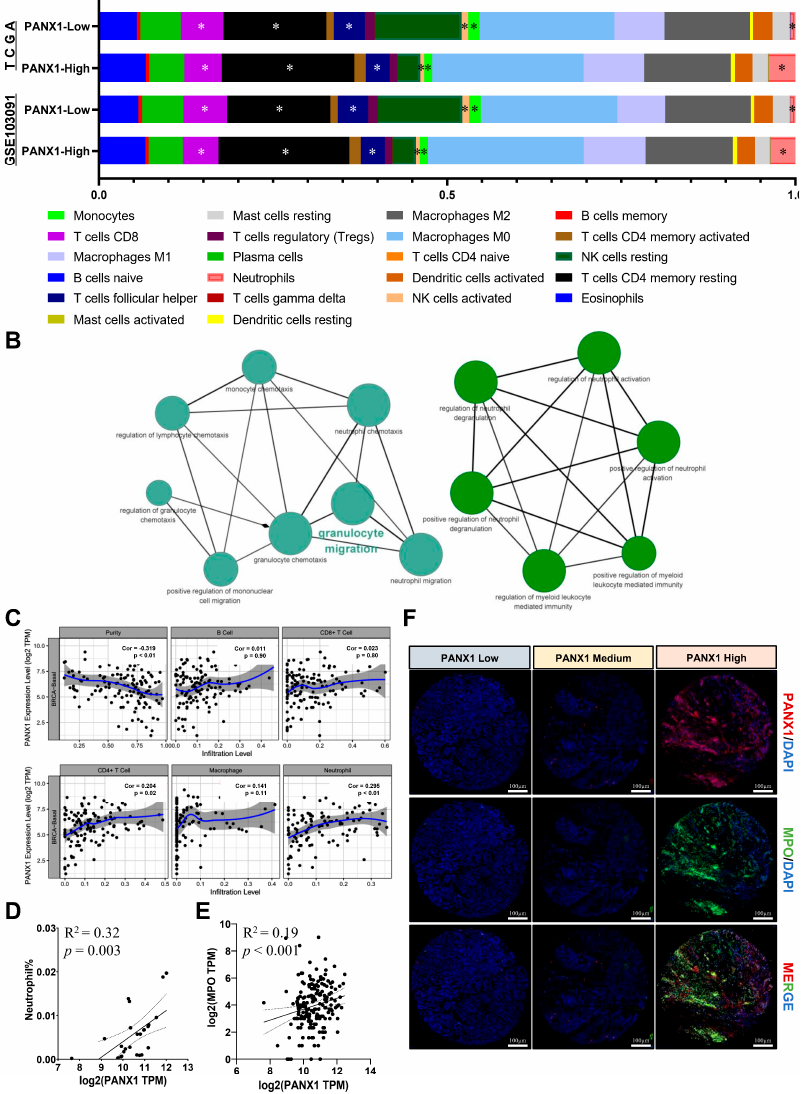
Figure 3. ( A ) CIBERSORT evaluated tumor-infiltrating immune cell (TIIC) differences under high (top 50%)/low (bottom 50%) PANX1 expression in basal-like subtype breast cancer (The key differ- ence immune cells are shown by star (* p < 0.05); TCGA-BRCA basal-like subtype (n = 186) and GSE103091(n = 238) data); ( B ) GO analysis of PANX1 and its coexpression immune-related genes; ( C ) TIMER analysis of PANX1 expression and TIIC correlation (TCGA-BRCA data; n = 1083; Spear- man’s rank correlation); ( D ) neutrophil abundance was positively correlated with PANX1 expres- sion in METABRIC basal-like subtype data (R 2 = 0.32; p = 0.003; Pearson’s correlation) (CIBERSORT algorithms; n = 25, outliers have been filtered); ( E ) MPO (neutrophil marker) expression was posi- tively correlated with PANX1 expression in TCGA-BRCA basal-like subtype data (n = 186; R 2 = 0.19; p < 0.001; Pearson’s correlation); ( F ) immunofluorescence detection of PANX1/MPO coexpression in basal-like breast cancer paraffin-embedded pathological specimens (DAPI, 4 ′ ,6-diamidino-phenyl- indole; MPO, myeloperoxidase).